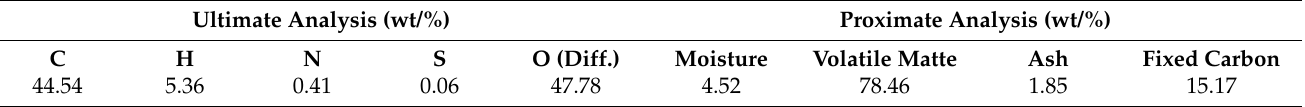
Table 1. The compositions of the pine sawdust obtained from ultimate and proximate analysis. Ultimate Analysis (wt/%) Proximate Analysis